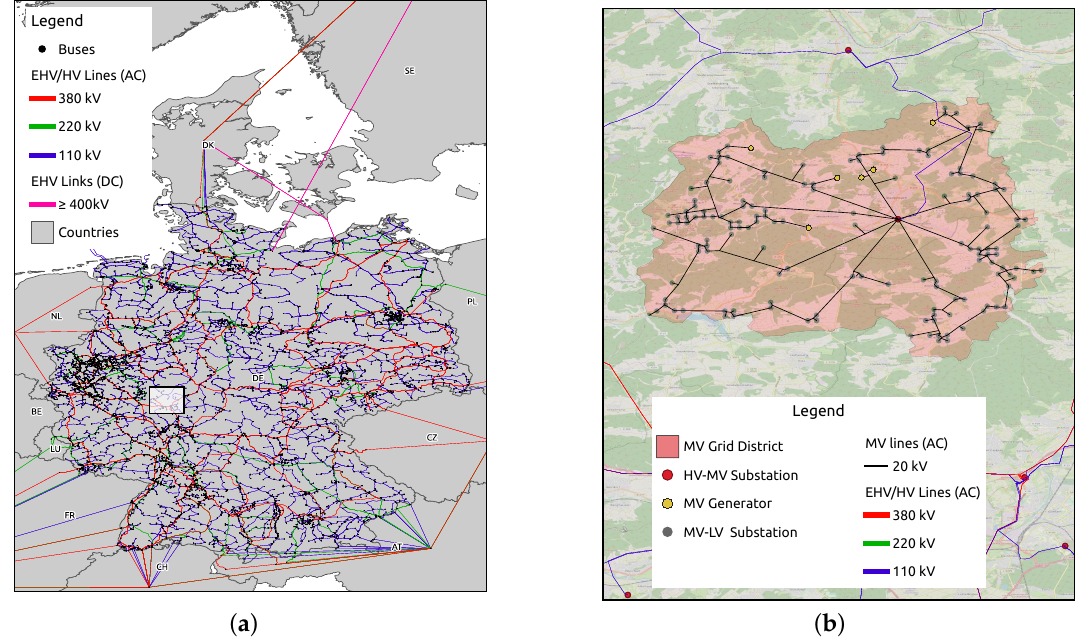
Figure 2. The Status Quo grid topology model for the EHV and HV level ( a ). In ( b ) one of the 3376 underlying MV grid topologies and its connection to the HV level is displayed. Its location corresponds to the zoom box in ( a ). The connected generation (except for MV generators in ( b )) and demand as well as transformers are not displayed for better visualization. A visualized bus which seems to connect two voltage levels is actually modelled as two buses connected by a transformer (see also